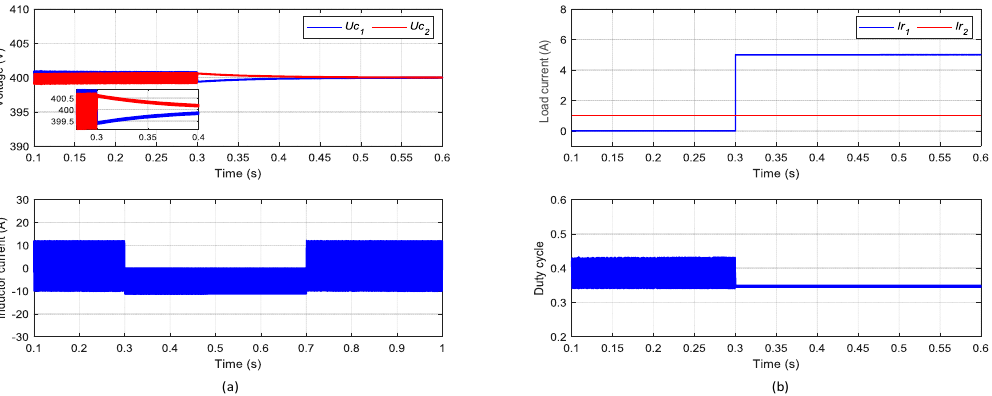
Figure 14. Numerical results with 50% capacitance nominal value using the proposed CCS – MPC. ( a ) Inductor current and output voltages. ( b ) Duty cycle and load current.